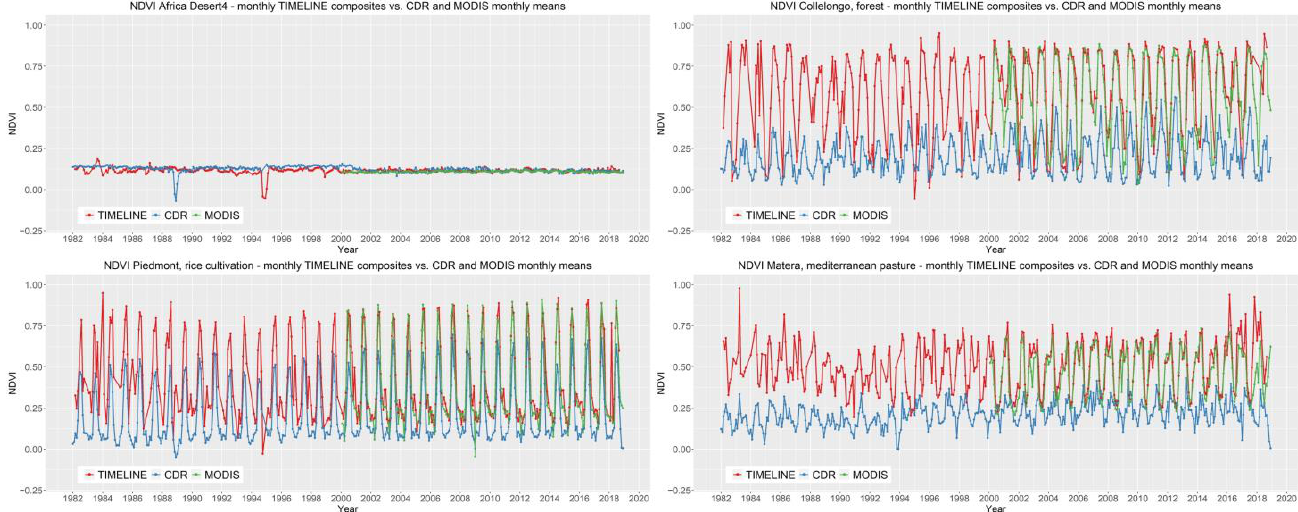
Figure 11. TIMELINE NDVI time series examples at four stations (the desert site “Africa desert 4” ( top left ); the forest site “Collelongo” ( top right ), the agricultural site “Piedmont” ( bottom left ), and the grassland site “Matera” ( bottom right )) in comparison to the CDR und MODIS products.